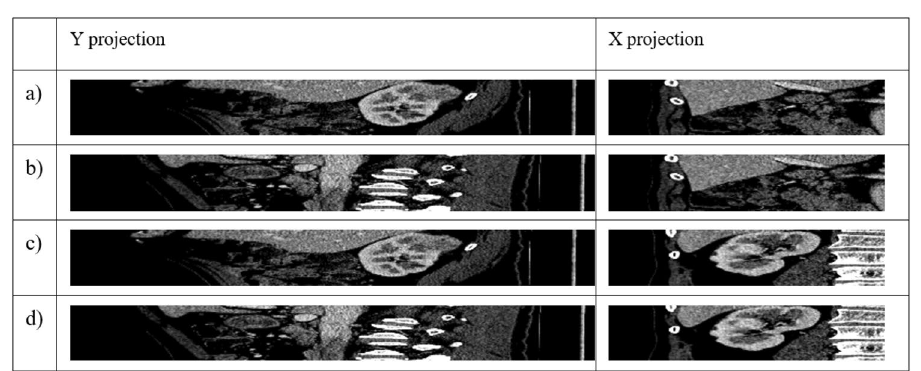
Figure 5. Cross-sections of the X and Y axes for points A, B, C and D, as shown in Fig.